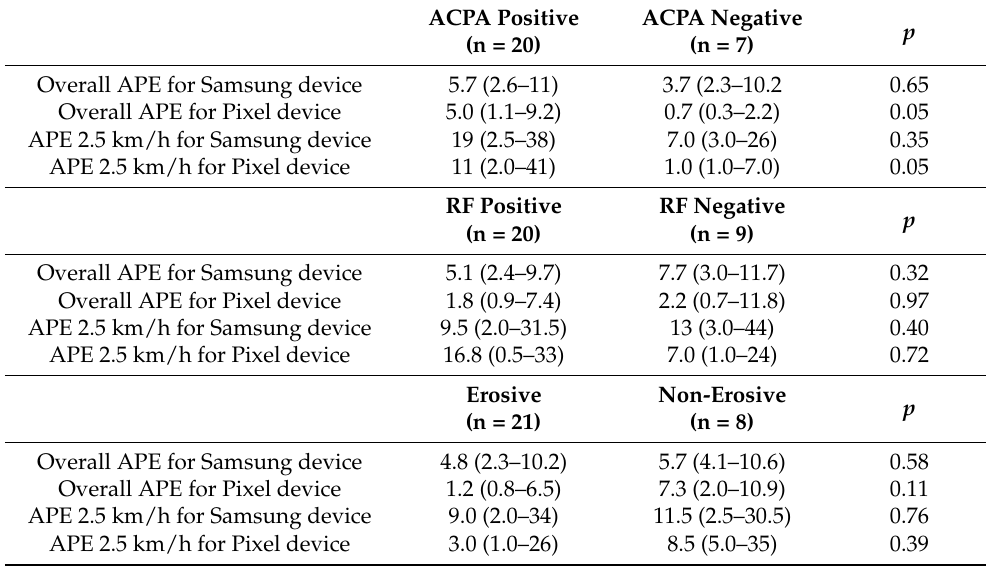
Table 5. Comparison between APE and dichotomous clinical